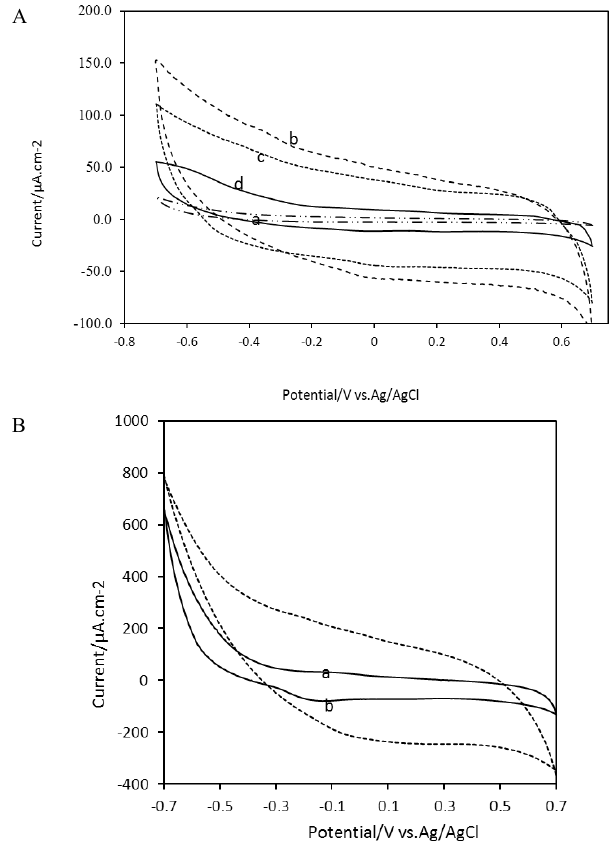
Fig. 3: (A) The CVs of naked GC (a), HOOC-MWCNT/GC (b), emim Tf N /HOOC-MWCNT/GC (c), ADH/emim Tf N /HOOC-MWCNT/GC 2 2 (d) electrodes. (B) The CVs of naked Cfelt (a), ADH/emim Tf N /HOOC- 2 MWCNT/Cfelt (b) electrodes. The experiment was carried out in PBS (0.1 M, pH 7.5) at scan rate of 50 mV.s -1